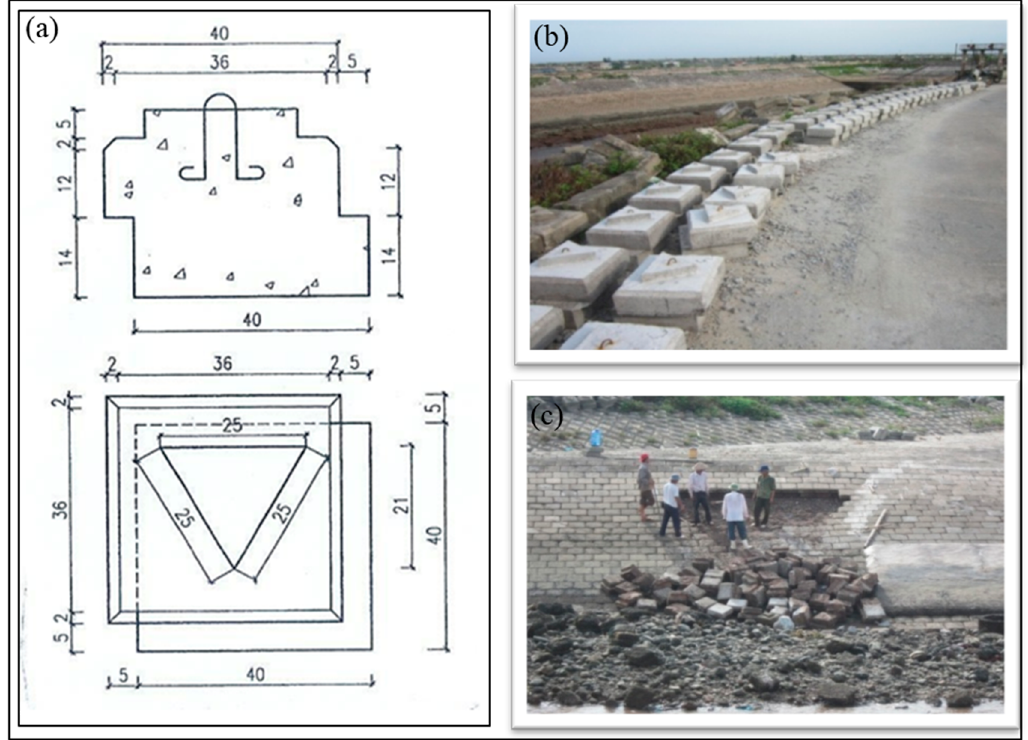
Figure 2. The components as prepared: ( a ) dimension of component (cm), ( b ) image of components, and ( c ) replacing components.